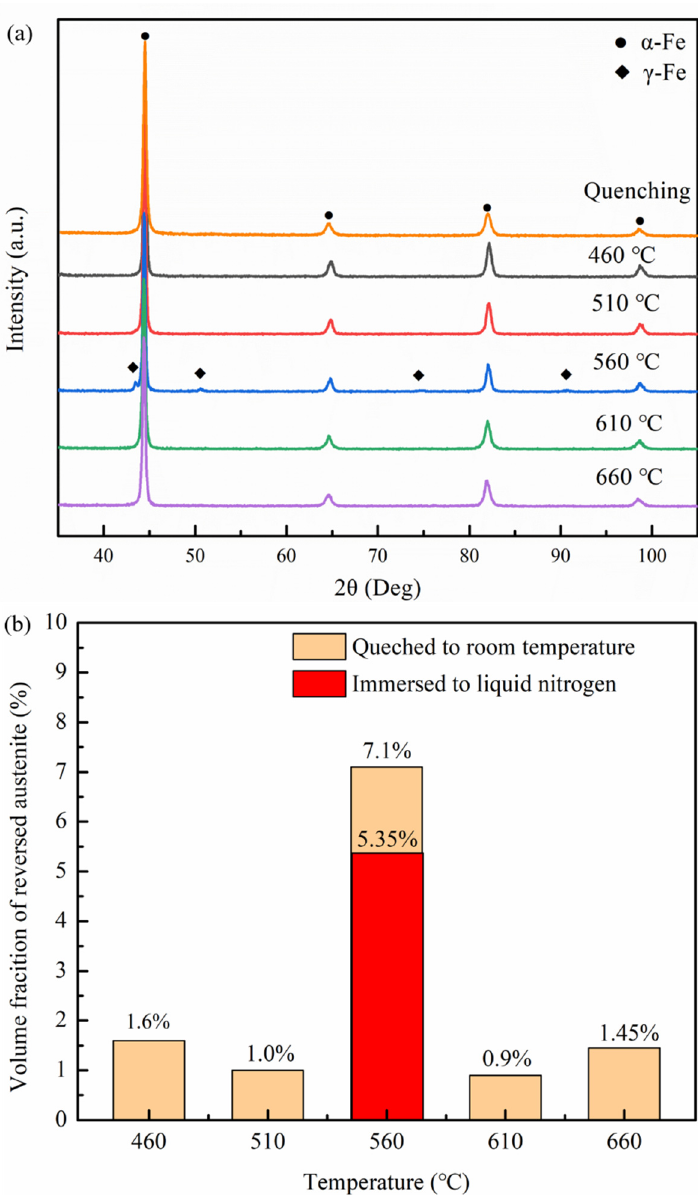
Figure 10. Austenite content and stability of Fe-9Ni-2Cu steel are reversed after quenching and tempering at different temperatures. ( a ) XRD; ( b ) low-temperature stability.